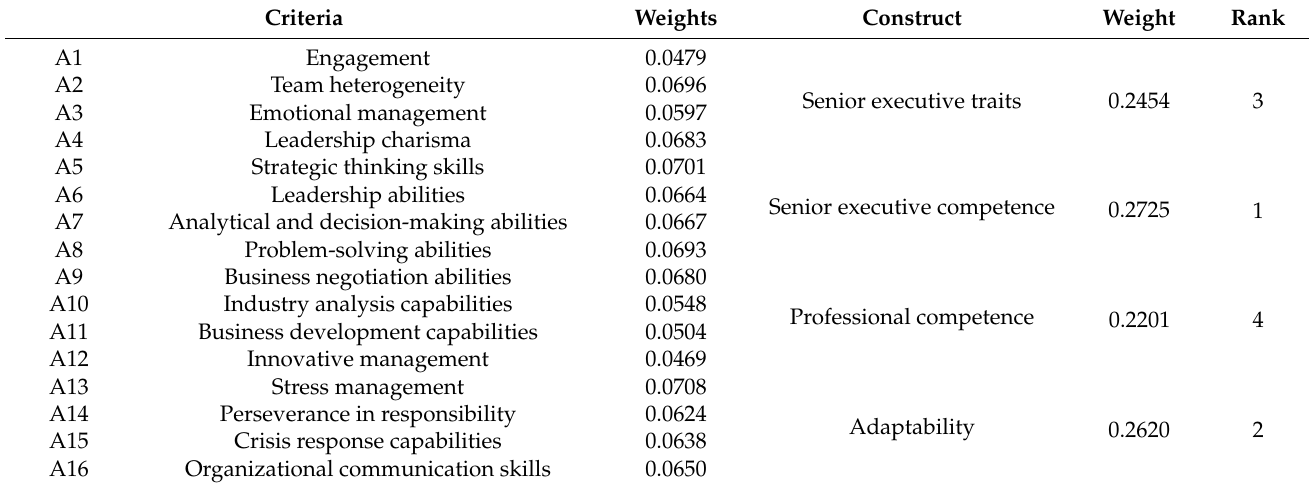
Table 10. F-DANP criteria